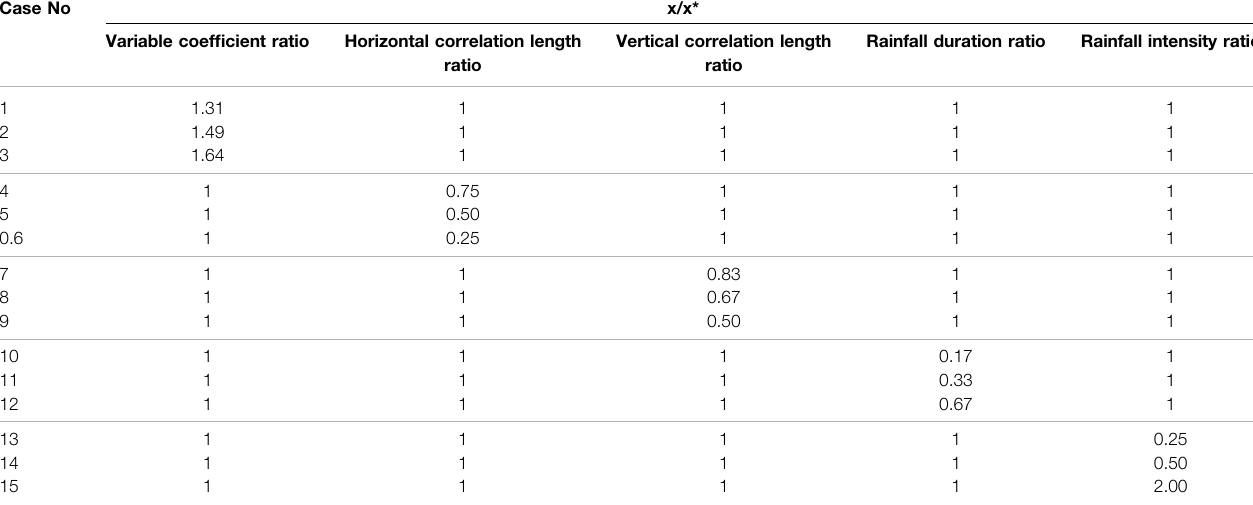
TABLE 2 | Ratios setting in different calculation